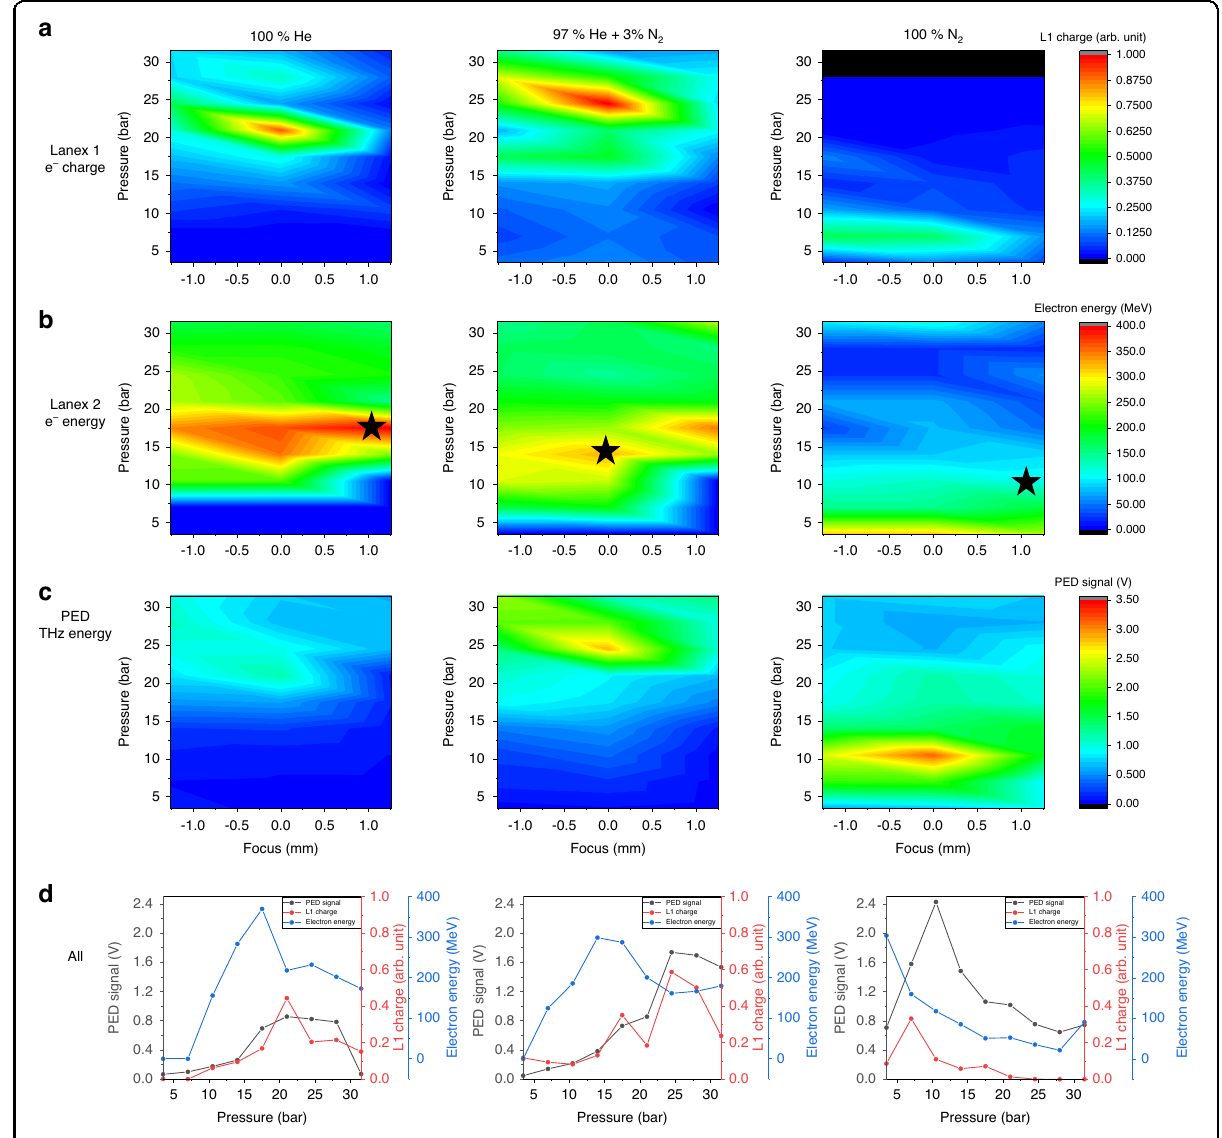
Fig. 3 Electron and THz properties. a Electron charge obtained from Lanex 1, b electron peak energy from Lanex 2, and c THz pyroelectric detector (PED) signal, all measured with varying the focal position ( x -axis) and gas backing pressure ( y -axis) for 100% helium, 97% helium mixed with 3% nitrogen, and 100% nitrogen gas targets. d Electron charge (red line), peak energy (blue line), and THz signal (black line) as a function of pressure. For ( a – c ), a 2-D contour color fi ll method was adopted, with real measurements made at three focal positions ( − 1.26, 0, and 1.26 mm) and nine pressures from 3.5 to 31.5 bar with an increment of 3.5 bar. The black stars represent the data selected for Fig. 2. The black stripe in ( a ) for 100% nitrogen indicates that no data was taken due to strong